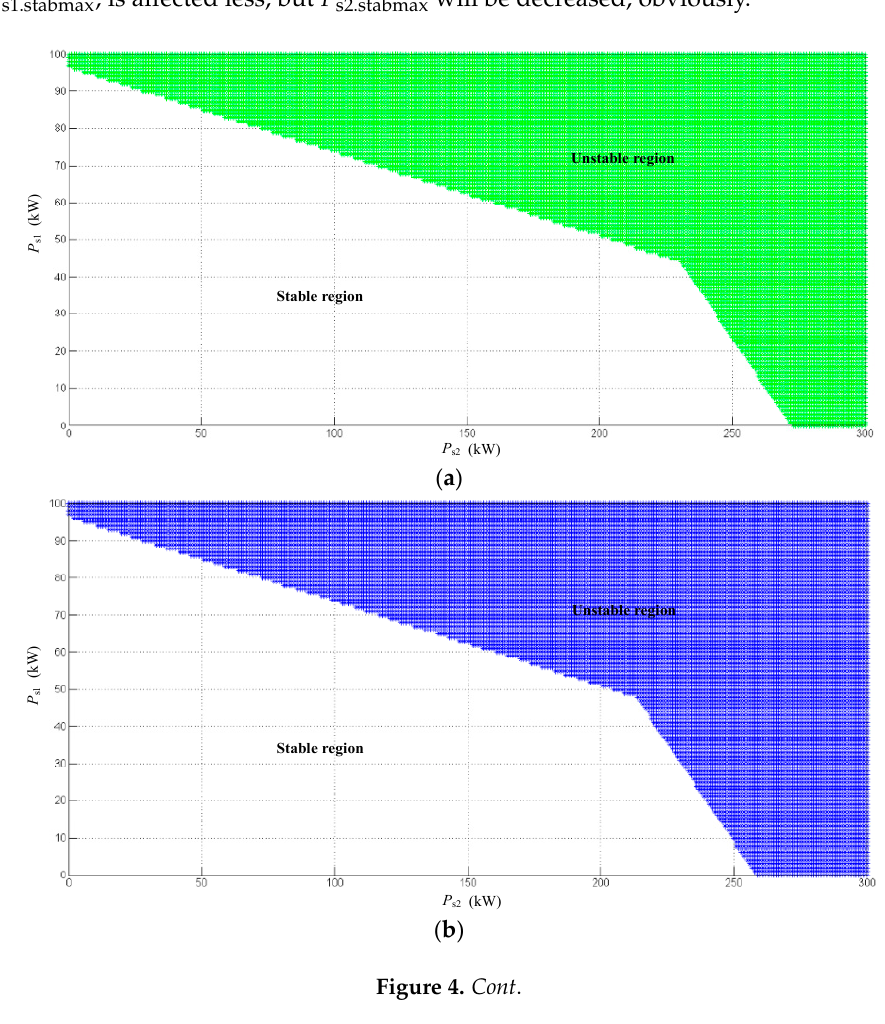
Table 1. Parameters of equivalent structure of LV multi-terminal AC/DC hybrid system.